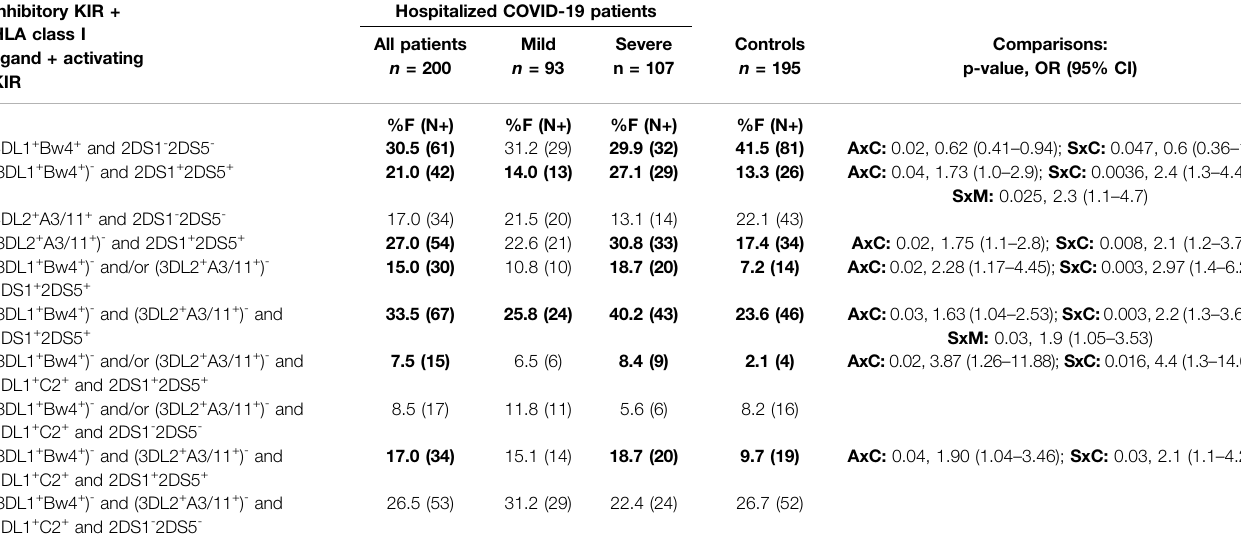
TABLE 4 | Frequency of inhibitory KIR, cognate HLA class I ligands, and activating KIR gene combinations in the control group and COVID-19 patients.